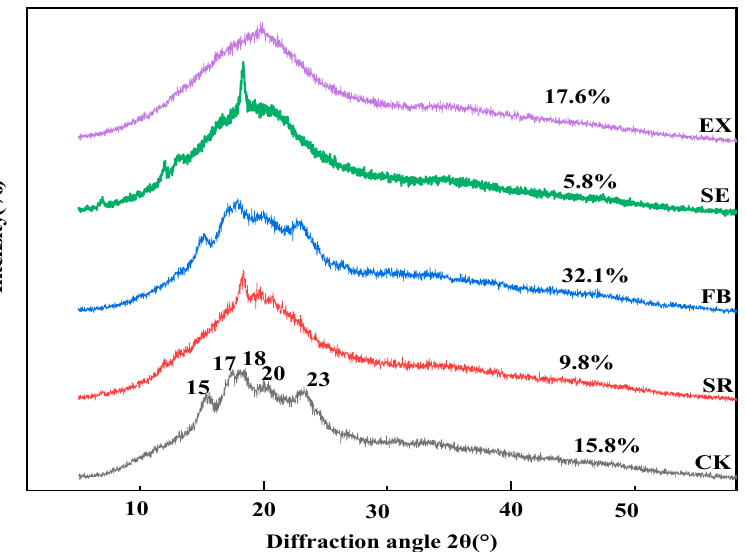
Figure 2. X-ray patterns of whole grain highland barley flour with different thermal treatments. CK: untreatment; SR: Sand-roasting; FB: Far-infraredBaking; SE: Steam Explosion; EX: Extrusion.